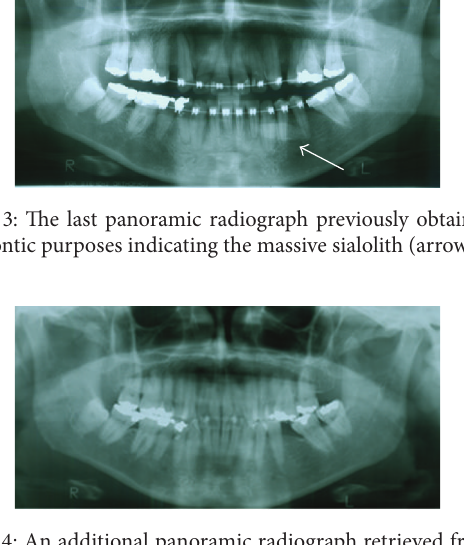
Figure 4: An additional panoramic radiograph retrieved from the patient’s file revealing no sign of sialolith